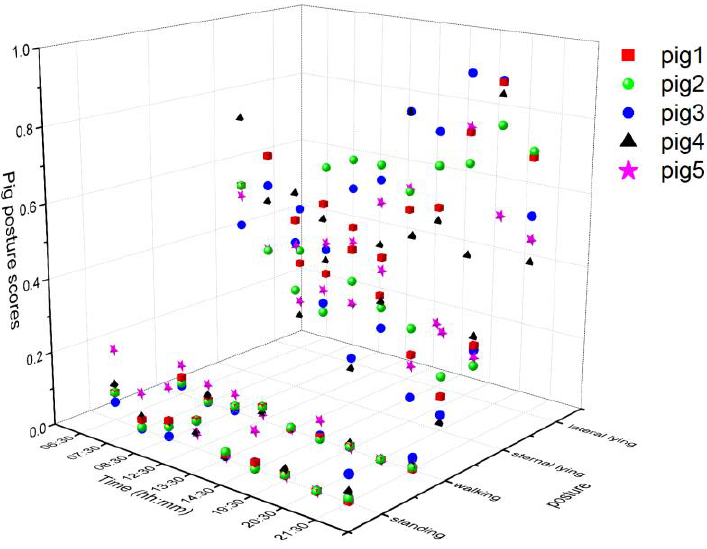
Figure 9. Posture and walking activity score profiles of individual pigs during the study period.